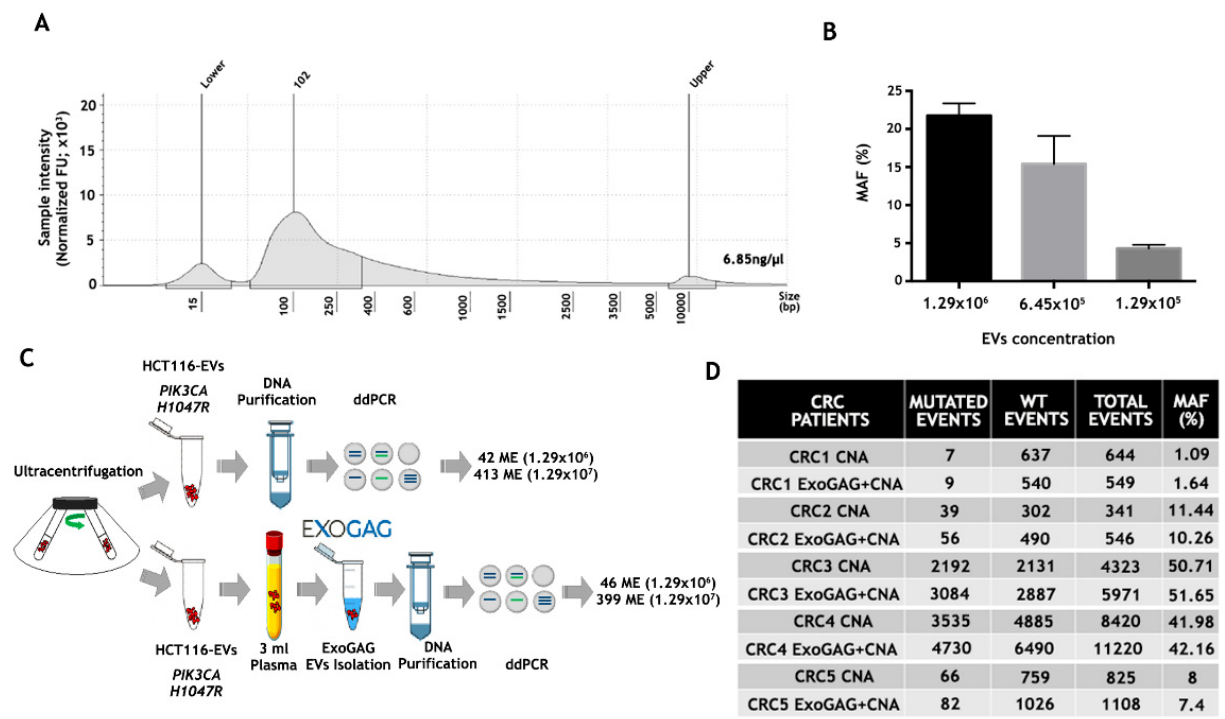
Figure 3. Analysis of point mutations by droplet digital PCR (ddPCR) in DNA from plasma EVs isolated by ExoGAG. ( A ) Quantification and fragment distribution of the EV-DNA purified from EVs isolated with ExoGAG from a plasma control sample analyzed by TapeStation4200 using High Sensitivity D5000 ScreenTapes Kit. ( B ) Histogram showing the percentage of MAF (% MAF) for the PIK3CA H1047R mutation in EVs isolated by ExoGAG from healthy donor (control) plasma samples